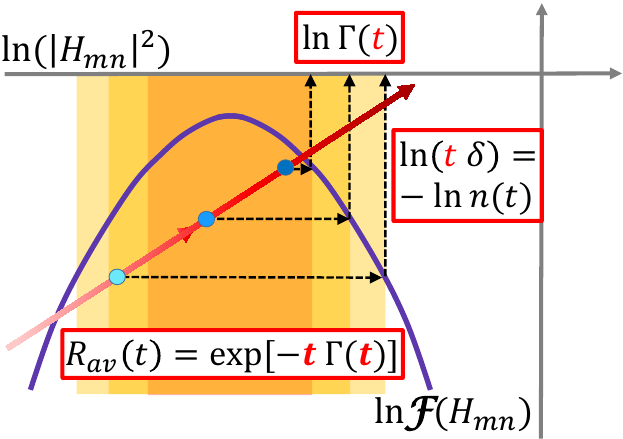
Figure 3: (Color online) Sketch of the mechanism of slow dynamics in the MF-RP ensemble . As time increases (the arrow of time is shown by the red diagonal line of varying intensity), the number of terms n in the sum, Eq. (24), is shrinking. This t | at the tails of the distribution leads to reduction of the interval of values of | H nm (shown by progressively shrinking yellow shaded areas) that one can “catch” having | , decreasing n “trial events”. As the decay rate Γ ( t ) is determined by rare large | H t nm | (shown by black the maximal value of the set of n random matrix elements | H t nm ( t ) slower dashed lines) results in decreasing Γ ( t ) with time, i.e. the behavior of R av than exponential. For a distribution with no tails (e.g. when the purple parabola | is time-independent, and the is very narrow) the typical maximal value of | H nm ( t ) is dynamics of R av